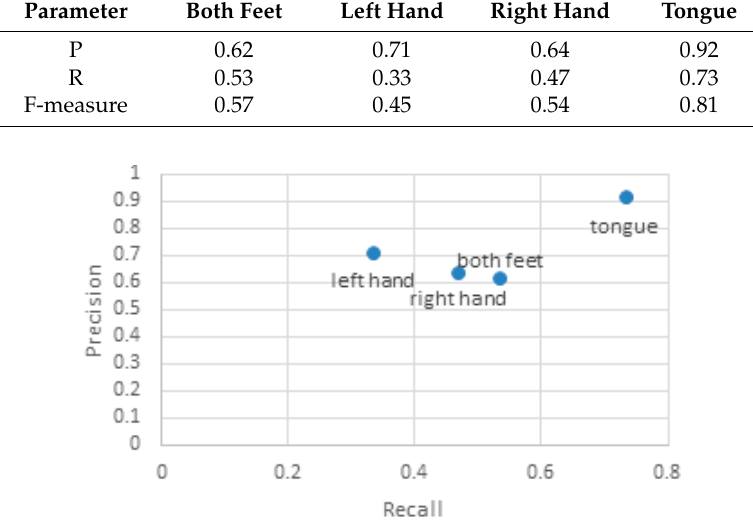
Figure 9. The precision and recall rate of the classification results of four-class motor imagery tasks: both feet, left hand, right hand, and tongue, for real-time MI EEG signals.